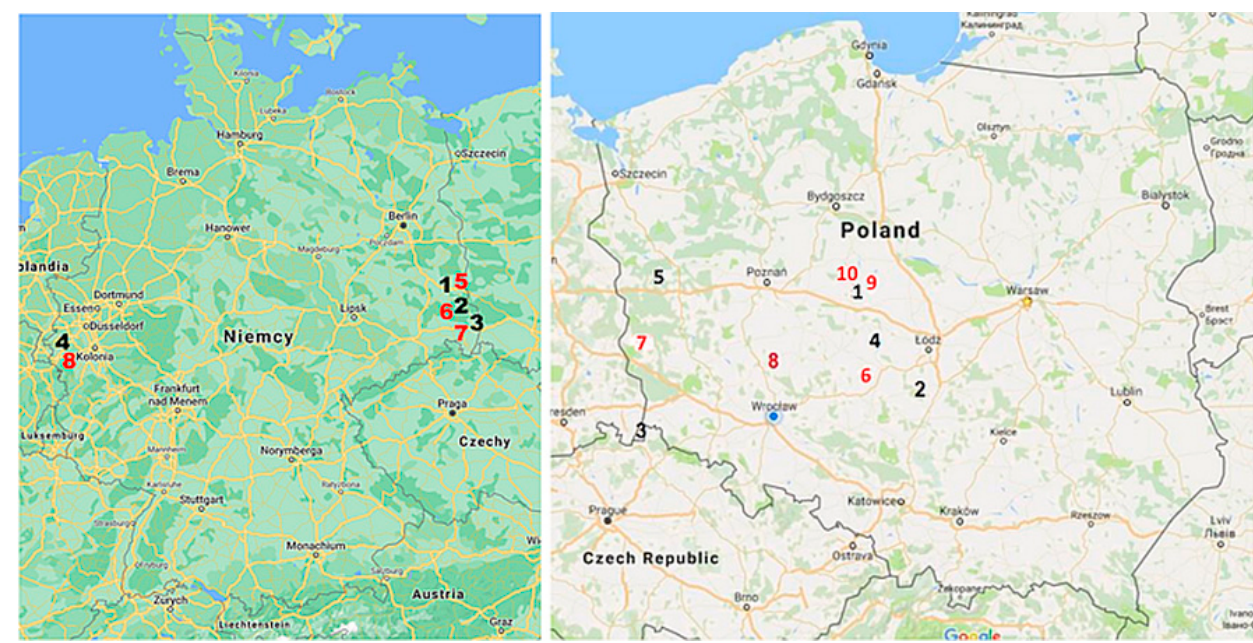
Figure 2. Location of exploited and prospective lignite deposits in Germany and Poland (Source: own elaboration). Table 2. Basic data on lignite deposits in